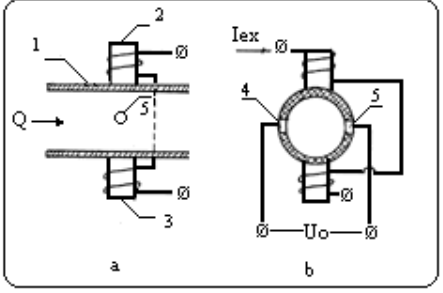
Figure 1. An electromagnetic flowmeter diagram.